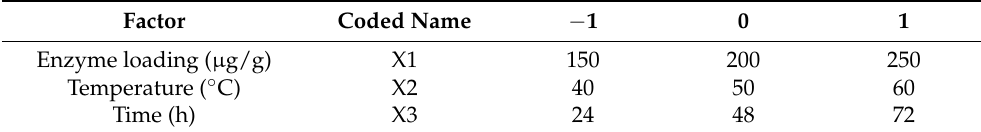
Table 1. Range and levels of independent process variables for enzymatic hydrolysis optimisation. Factor Coded Name − 1 0